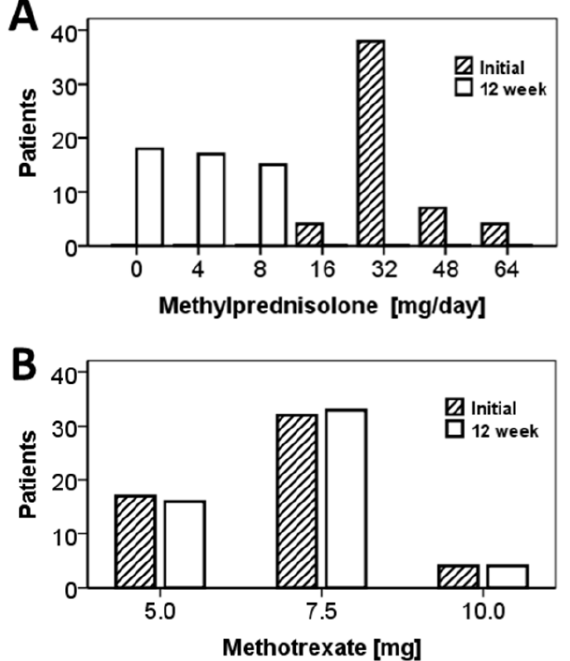
Figure 2. Distribution of daily MP doses ( A ) and weekly MTX doses ( B ) at treatment start and at the 12-week follow up.